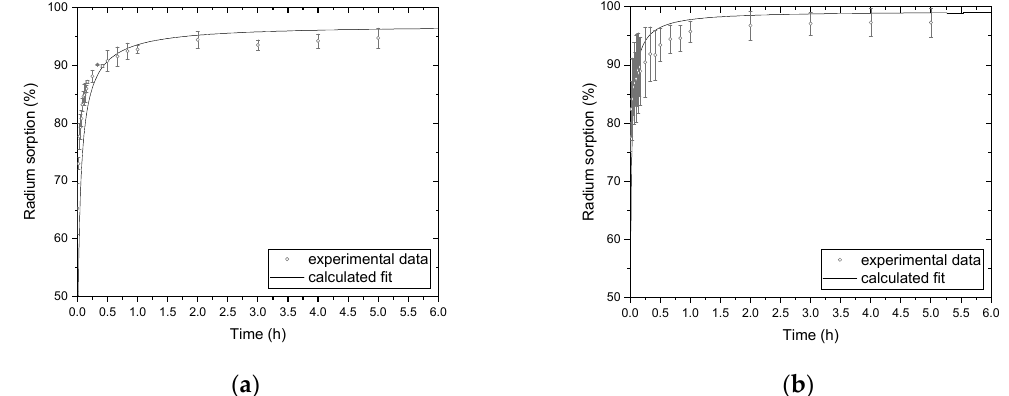
Figure 1. The kinetic of 223 Ra sorption on nanoparticles (NPs) during the first hour: ( a ) n HAp (mean initial concentration c 0 = 1.02 × 10 − 11 mol/L) and ( b ) n TiO 2 (mean initial concentration c 0 = 1.01 × 10 − 11 mol/L). Table 5. The values of over-all kinetic, K RLD , and diffusion, D , coefficients, and half-life of sorption, t ½ , for the diffusion in reacted layer (RLD) model.